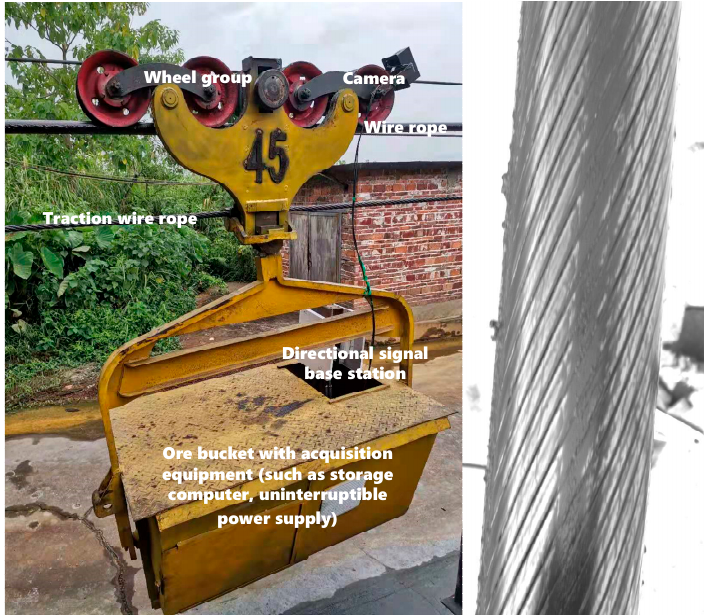
Figure 12. Steel wire image acquisition system.